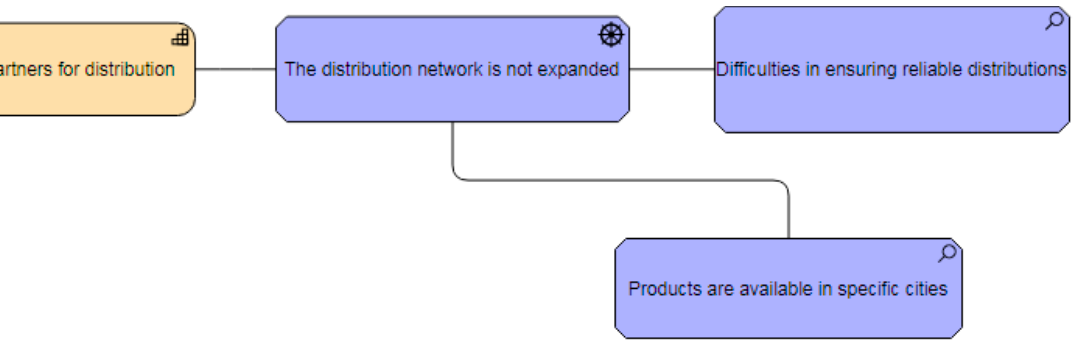
Figure 7. The link between capabilities and external factors.